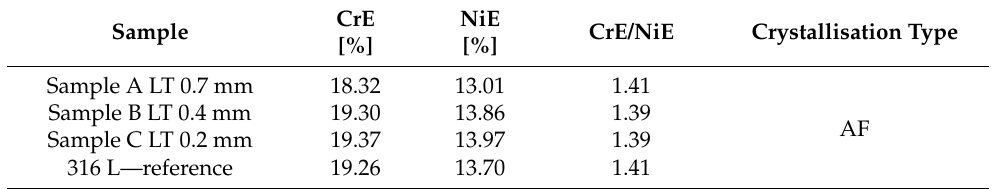
Table 6. Chromium and nickel equivalents, the coefficient of CrE/NiE, and the type of crystallisation.